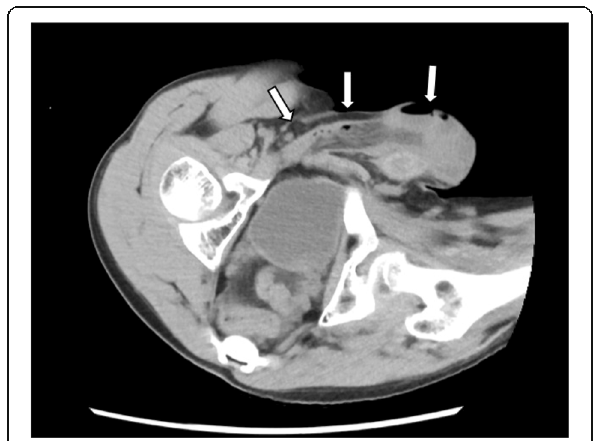
Fig. 1 Computed tomography showed an indirect inguinal hernia on the right